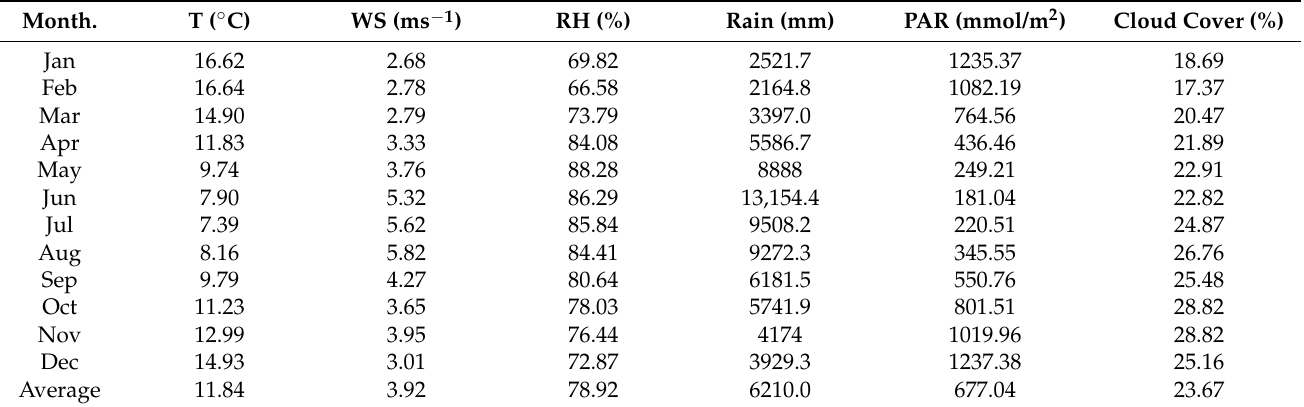
Table 1. Meteorological and radiometric parameters in Lake